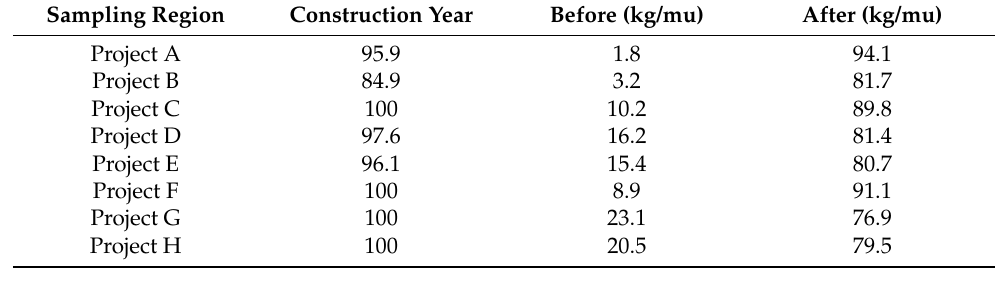
Table 7. Statistical data on the proportion of middle–low productive cropland before and after the sampling project regions.